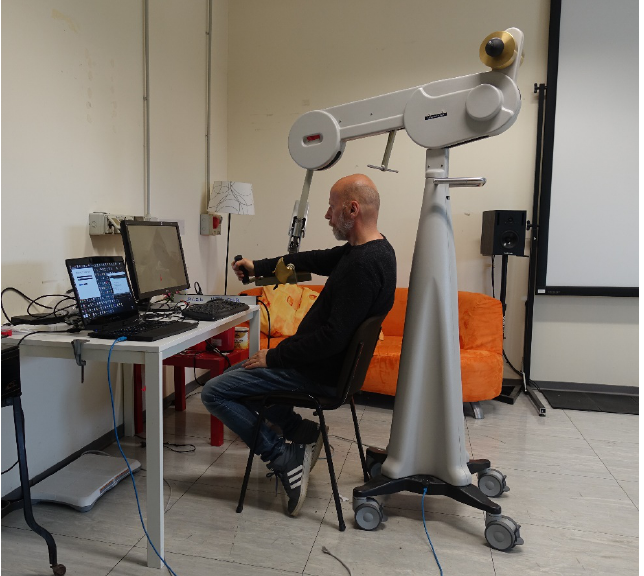
Figure 8. Side view of the system, with operator monitor (laptop) and larger display monitor for the